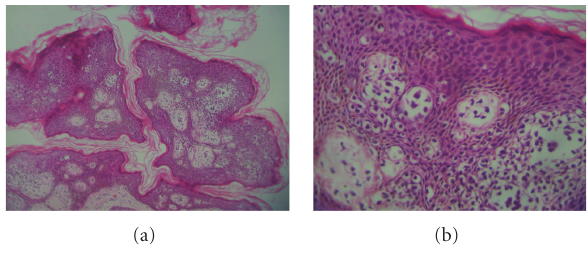
Figure 6: (a) The skin biopsy from buttocks (patient 3) shows extensive epidermal changes with marked epidermotrophism of lymphocytes (Hematoxylin-eosin stain, original magnification × 100). (b) Greater magnification highlights atypical lymphocytes and formation of numerous ( > 3) Pautrier’s microabscesses (H&E stain, 400x).